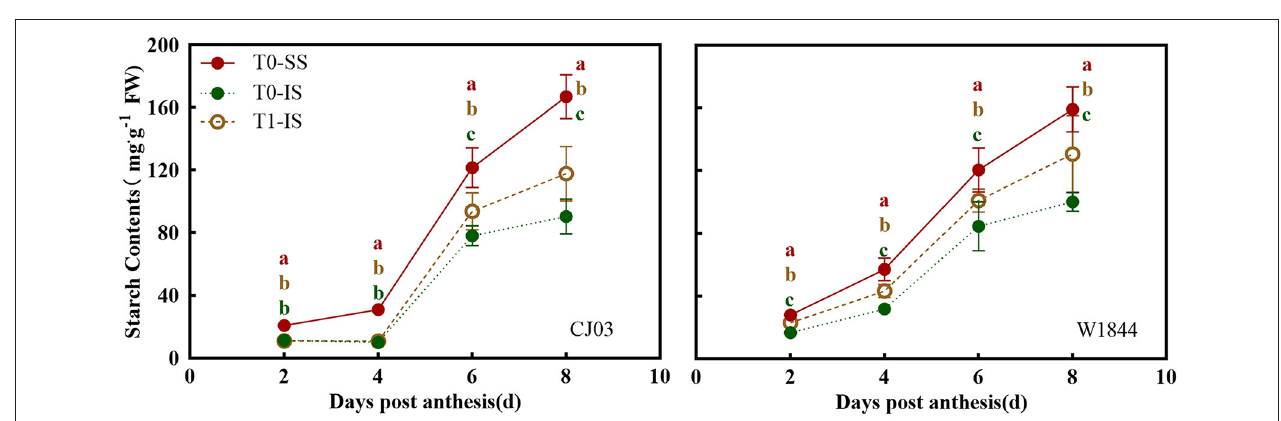
FIGURE 4 | Starch content in developing grains of CJ03 and W1844. The T0-control group without any treatment; T1- top 2/3 of the spikelets were removed. Colored letters indicate statistically significant differences between days of the same treatments at the P = 0.05 level.